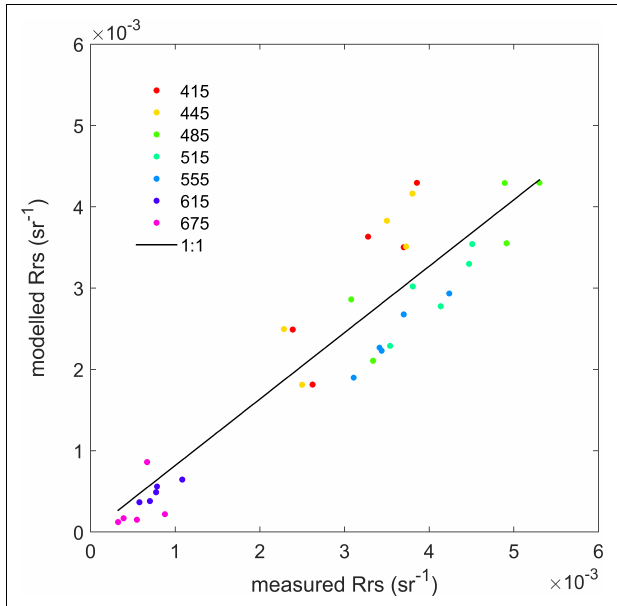
FIGURE 12 | Optical closure of Rrs. Line of 1:1 agreement between the measured and modeled remote sensing reflectance (Rrs) at wavelengths 415, 445, 485, 515, 555, 615, and 675